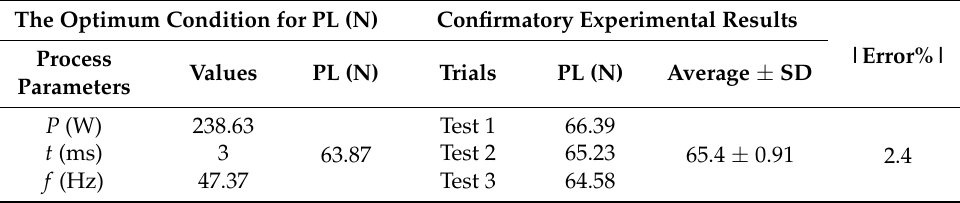
Table 6. Confirmatory/validation test results.